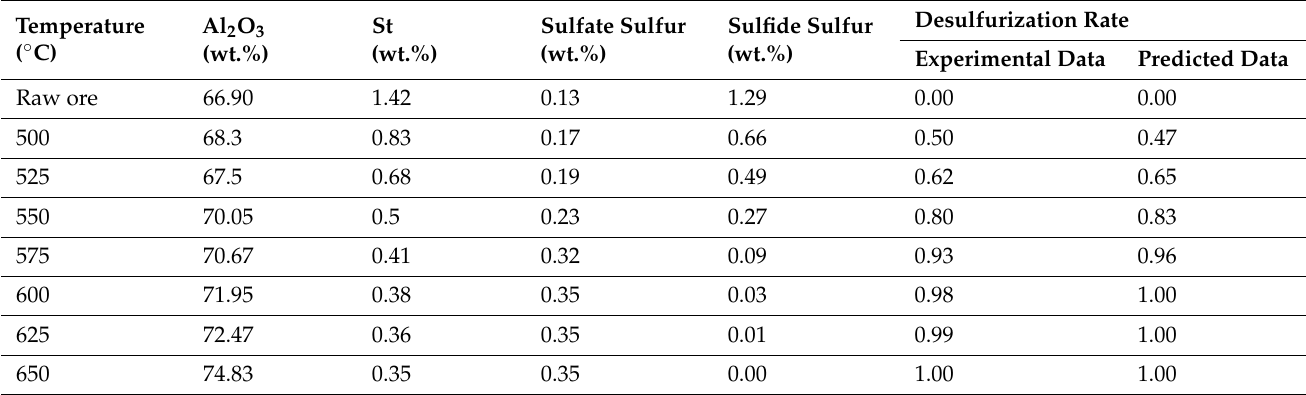
Table 4. Analysis results of the desulfurization rate of roasted high-sulfur